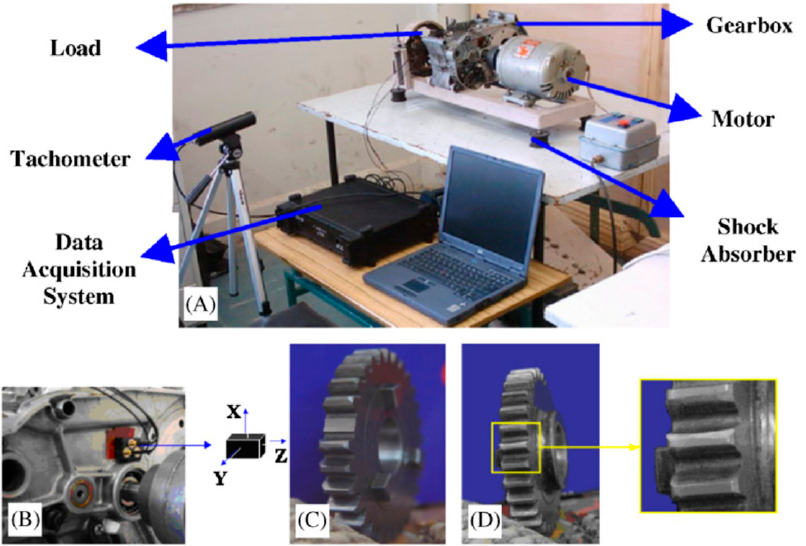
Figure 2. Experimental rig for simulations of gear faults, ( A ) experimental rig, ( B ) accelerometer location, ( C ) broken tooth, and ( D ) slightly worn tooth [25,26].